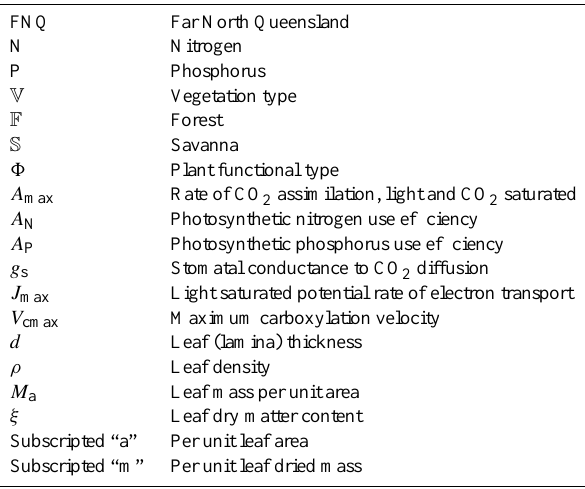
Table 1. Key symbols and